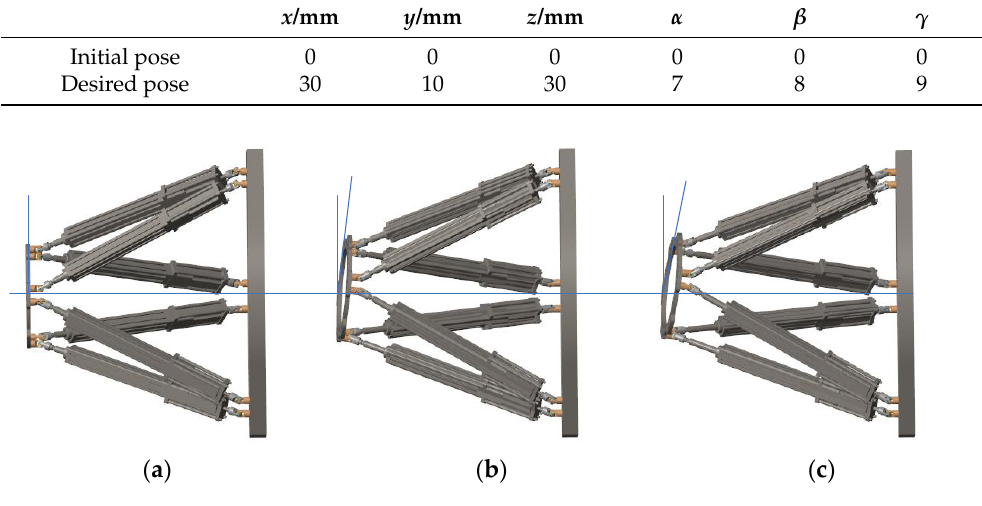
Figure 14. ( a – c ) are the process of FRR 3D model.